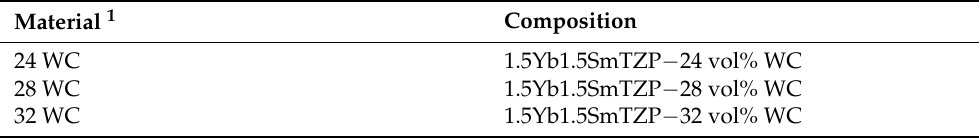
Table 1. Net compositions of the TZP-WC pressing feedstocks. Material